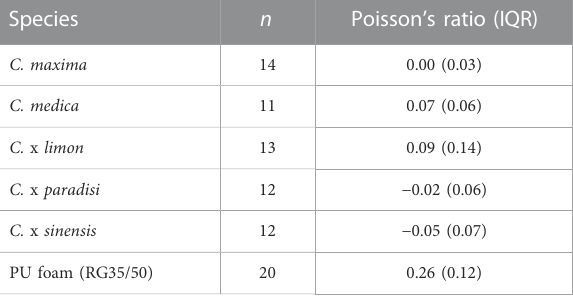
TABLE 6 Median Poisson ’ s ratios at 10% axial strain for the tested citrus species: pomelo ( C. maxima ), citron ( C. medica ), lemon ( C. x limon ), grapefruit ( C. x paradisi ), orange ( C. x sinensis ), and for PU foam (RG35/50).